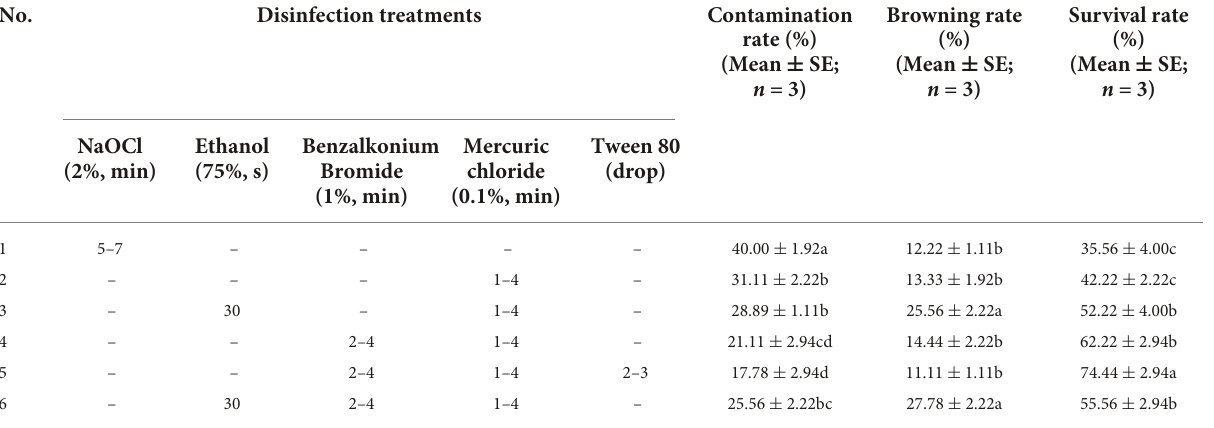
TABLE 1 Effects of different disinfection treatments on the survival of explants. No.